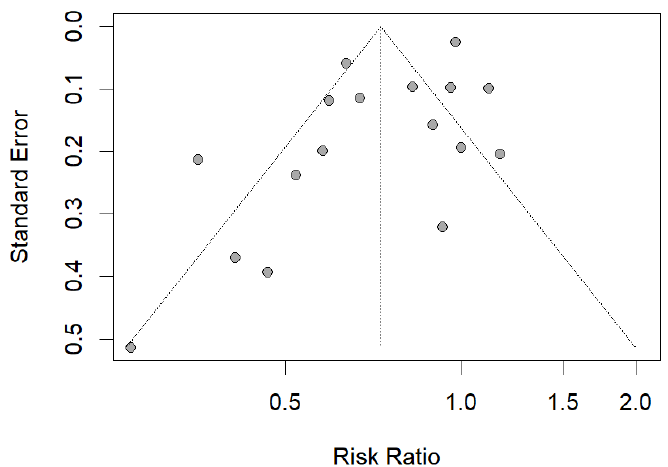
Figure 3. Funnel plot based on study standard error and risk ratio in assessing publication bias.